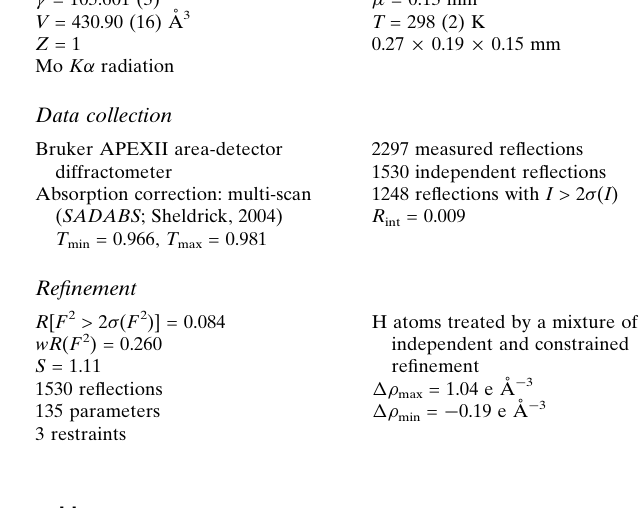
In the crystal structure of the title compound, (cid:1) 2H H N O O, the organic molecule is located on a C 16 10 2 8 2 centre of symmetry. The two benzene rings are parallel, but not coplanar, as indicated by N N—C—C torsion angles involving the azo group of 12.1 (5) and (cid:2) 168.2 (3) (cid:3) . The organic molecule and the water molecule are linked by O—